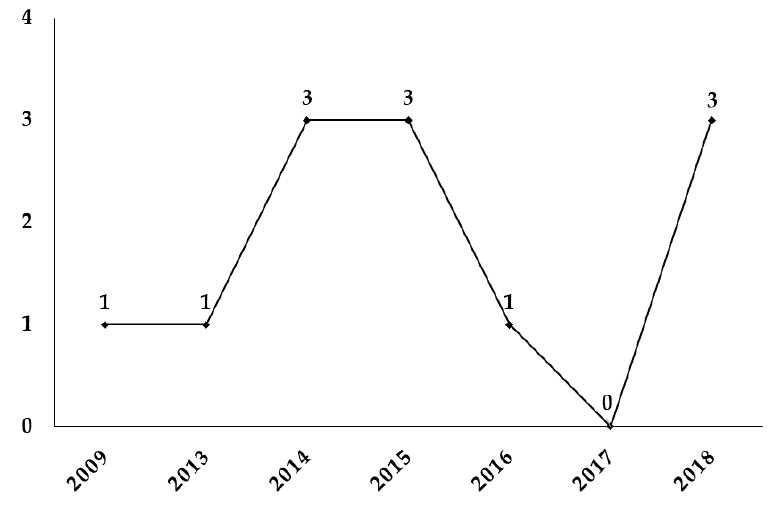
Figure 2. Number of articles per year.